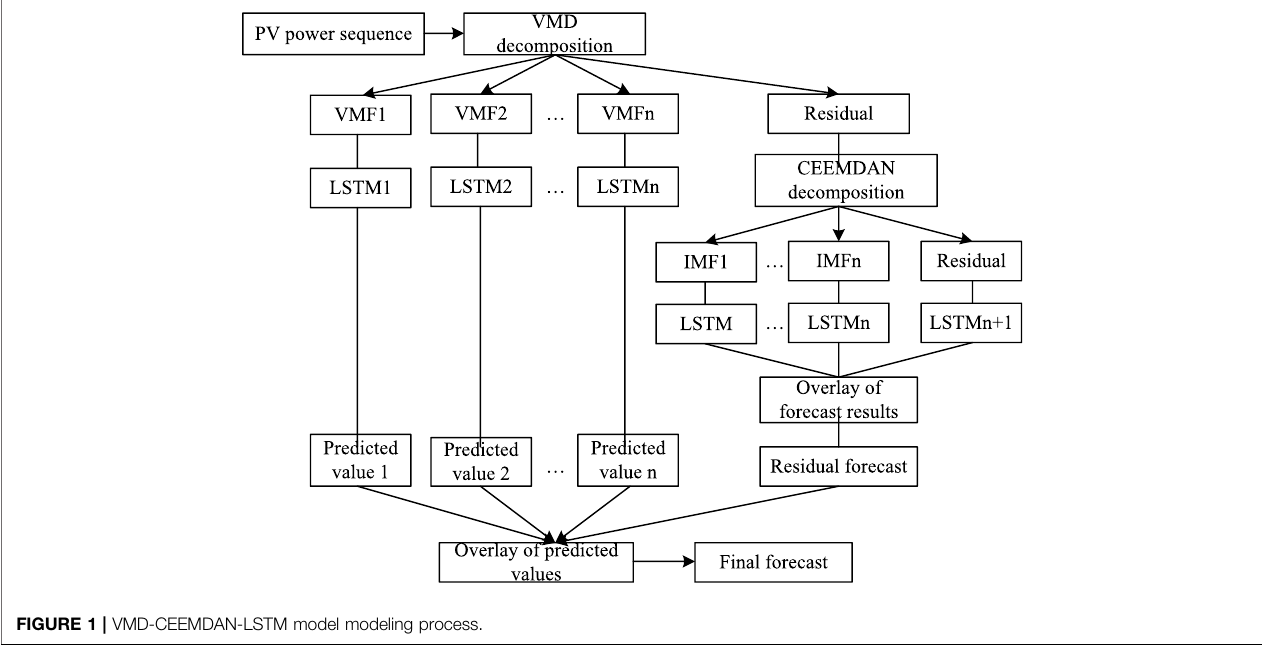
FIGURE 1 | VMD-CEEMDAN-LSTM model modeling process.